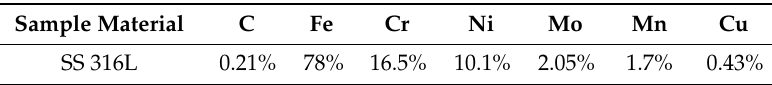
Table 2. Chemical composition of SS 316L, raw material prior to fabrication.